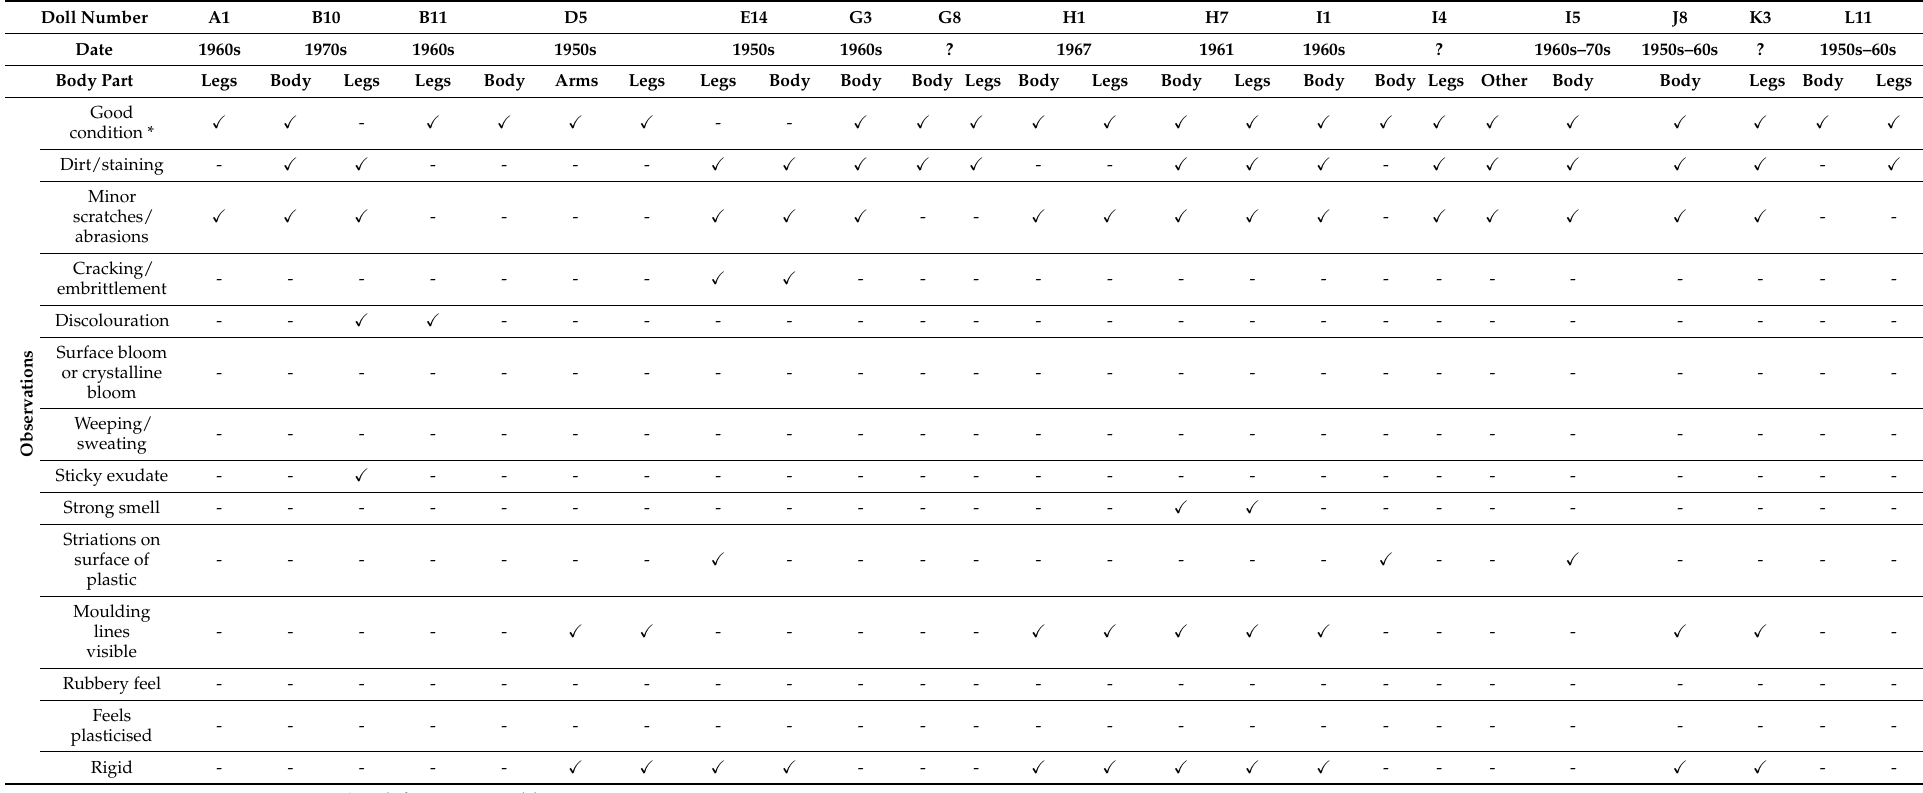
Table 3. Summary of condition of the dolls identified as having PE